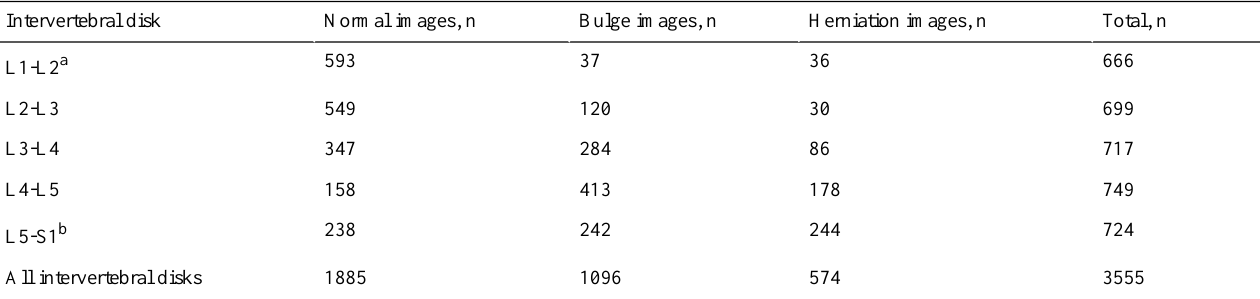
Table 1. The number of axial images in each